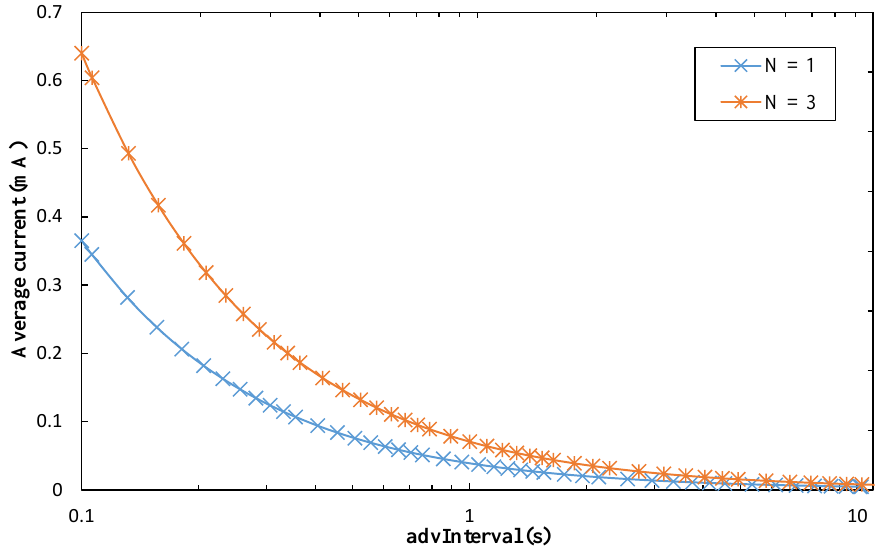
Figure 9. Average current consumption of the sensor node in the advertisement-based approach, as a function of advInterval , and for both N = 1 and N = 3.